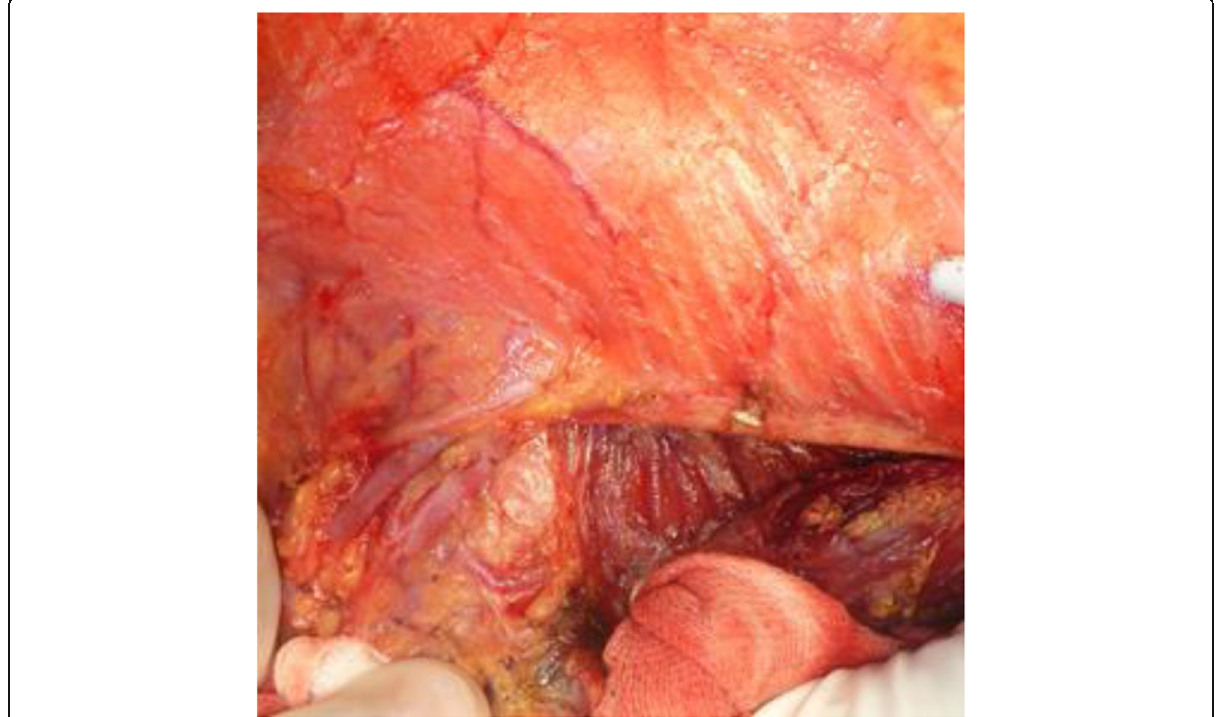
Fig. 22 Nerve traveling below lower border behind the facial